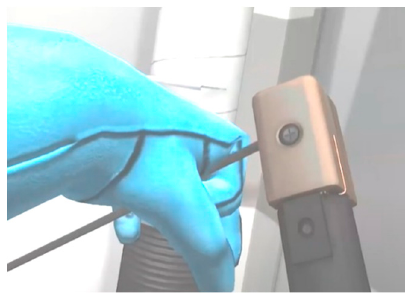
Figure 12. VR Welding Simulation Screen.